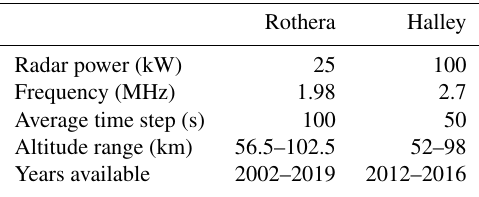
Table 1. Basic information on the operation characteristics of the two radars. Rothera Halley Radar power